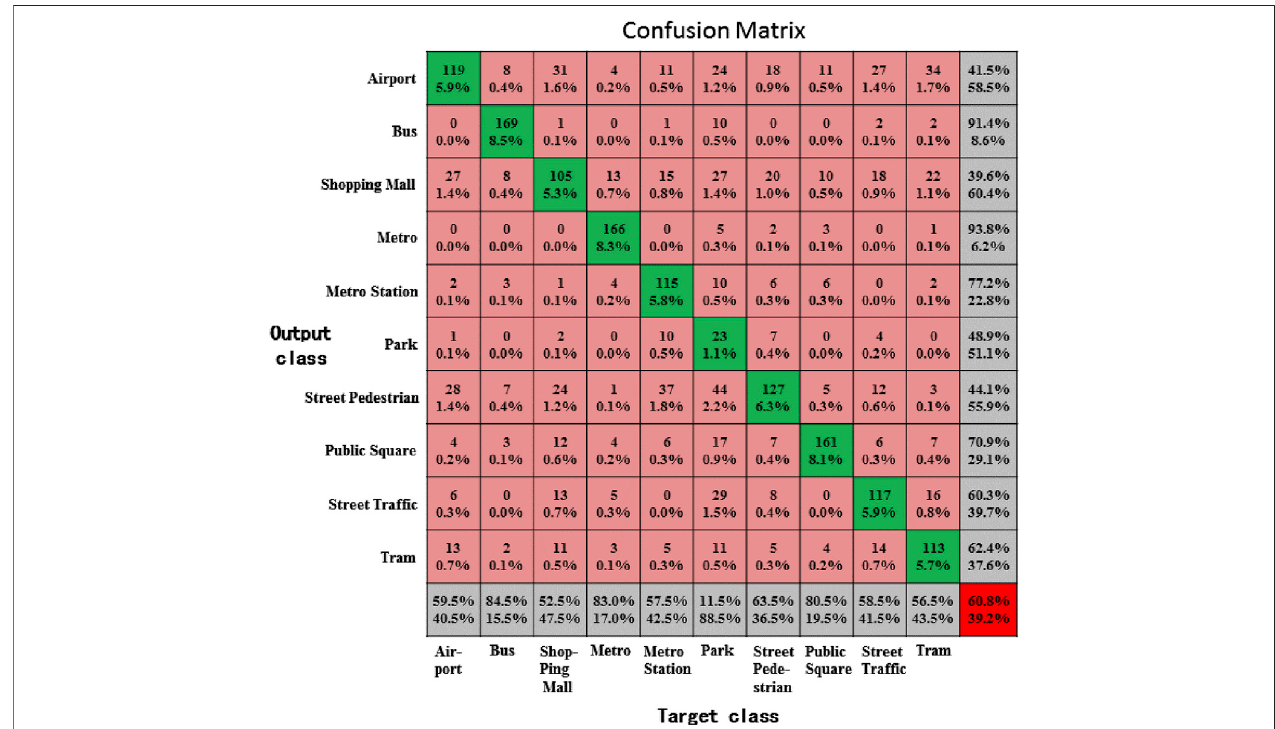
FIGURE 9 | Recognition results of basic instantaneous frequency and instantaneous amplitude features.